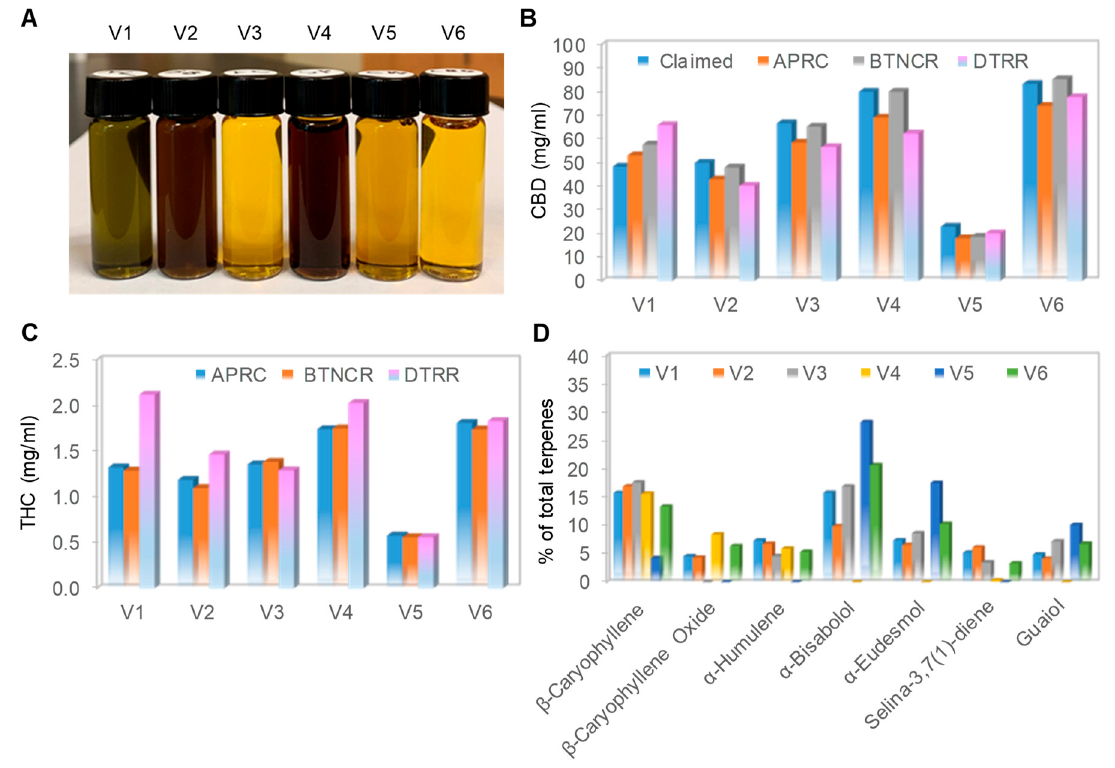
Figure 1. Physical and chemical profiles of CBD oils. ( A ) Physical appearance of six cannabidiol (CBD) oils captured with a standard digital camera; ( B ) claimed and measured CBD concentrations in the six CBD oils. Claimed CBD concentration (blue) and measured CBD concentrations by Aromatic Plant Research Center (APRC, orange), Botanacor (BTNCR, gray), and d¯oTERRA (DTRR, pink); ( C ) measured tetrahydrocannabinol (THC) concentration in the six CBD oils. Measured THC concentrations by APRC (blue), BTNCR (orange), and DTRR (pink). CBD and THC concentrations were independently measured by HPLC methods at three di ff erent laboratories: APRC, BTNCR, and DTRR; ( D ) major aroma compounds as a percentage of total terpenes in the six CBD oils. The terpene profiles were measured by a GC-MS method at APRC. CBD oil V1 (blue), V2 (orange), V3 (gray), V4 (yellow), V5 (blue), and V6 (green).